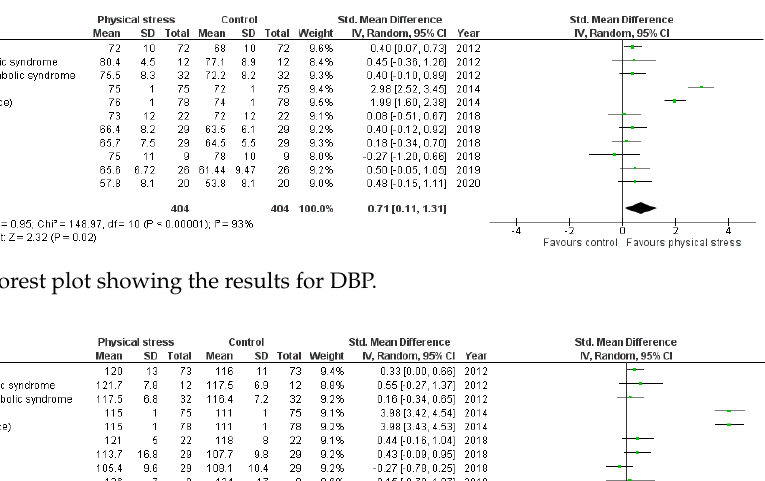
Figure 5. Forest plot showing the results for SBP.